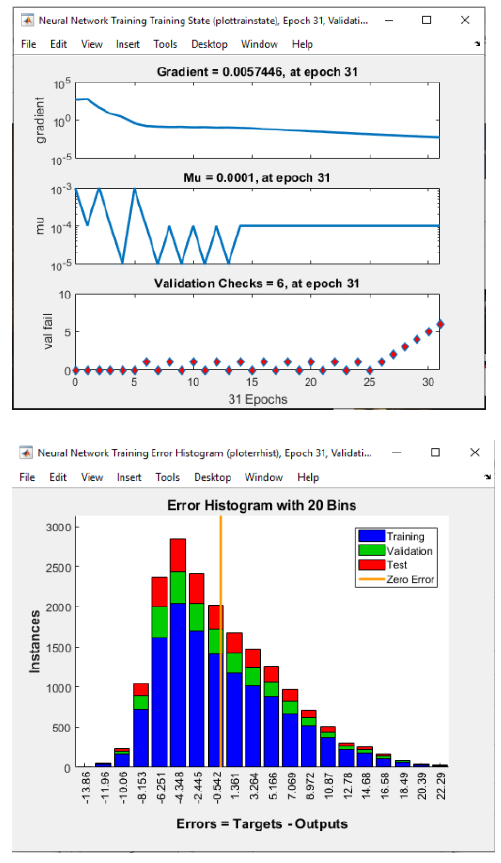
Figure 11 . shows the error histogram of the trained neural network for the training, validation and testing steps. This figure